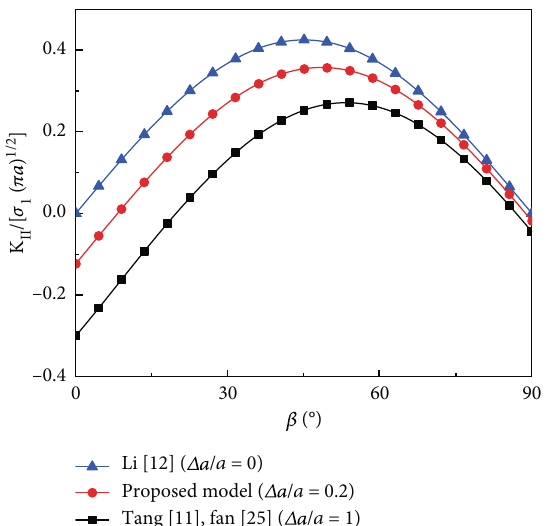
Figure 9: Comparison of the variation of normalized stress intensity factor as a function of crack inclination angle obtained from the proposed and the previous theories.